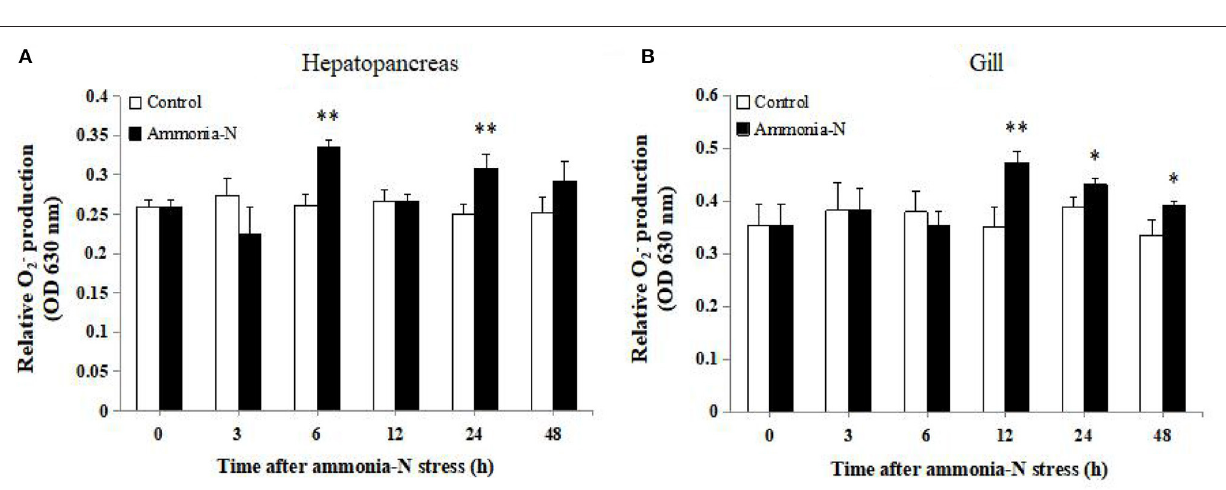
FIGURE 7 | Analysis of O − 2 production in (A) hepatopancreas and (B) gill of ammonia-N stress and control groups at 0, 3, 6, 12, 24, and 48h post stress ( n = 9). Statistical significance was calculated using Statistical Package for the Social Sciences (SPSS) 18.0 (* P < 0.05; ** P < 0.01; *** P < 0.001). in dsGrx 3-injected shrimps were lower at 6–24 h exposure ( P <